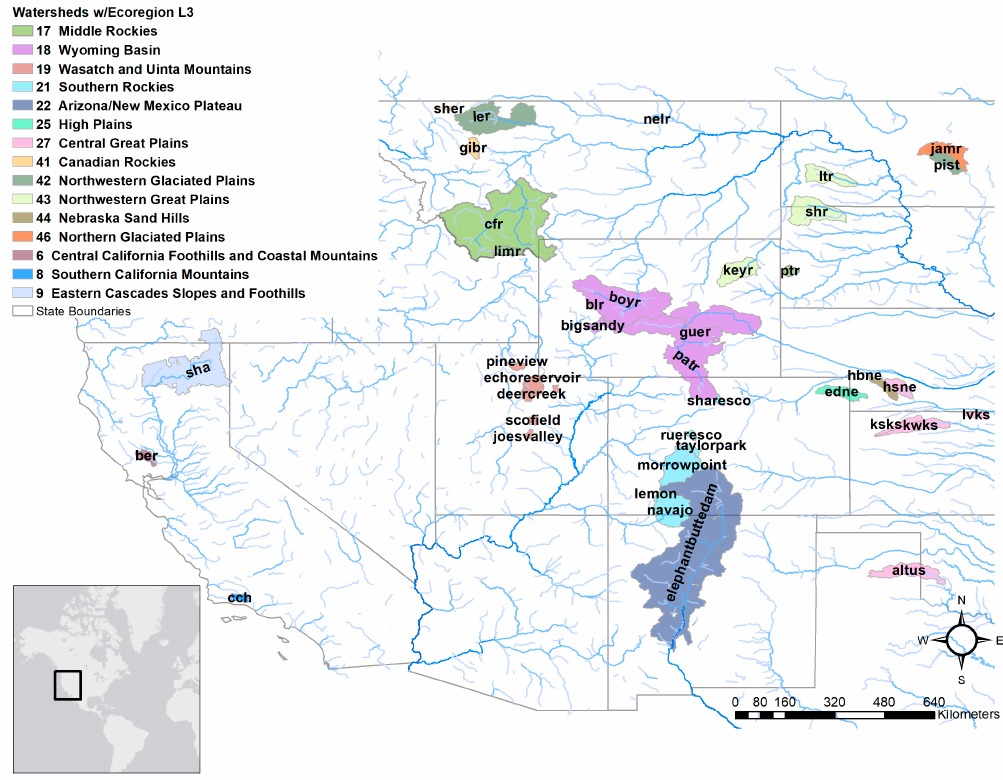
Figure 1. Map of watersheds for the 42 reservoirs included in this study; polygons are colored according to the level three Ecoregion with the dominant land area.